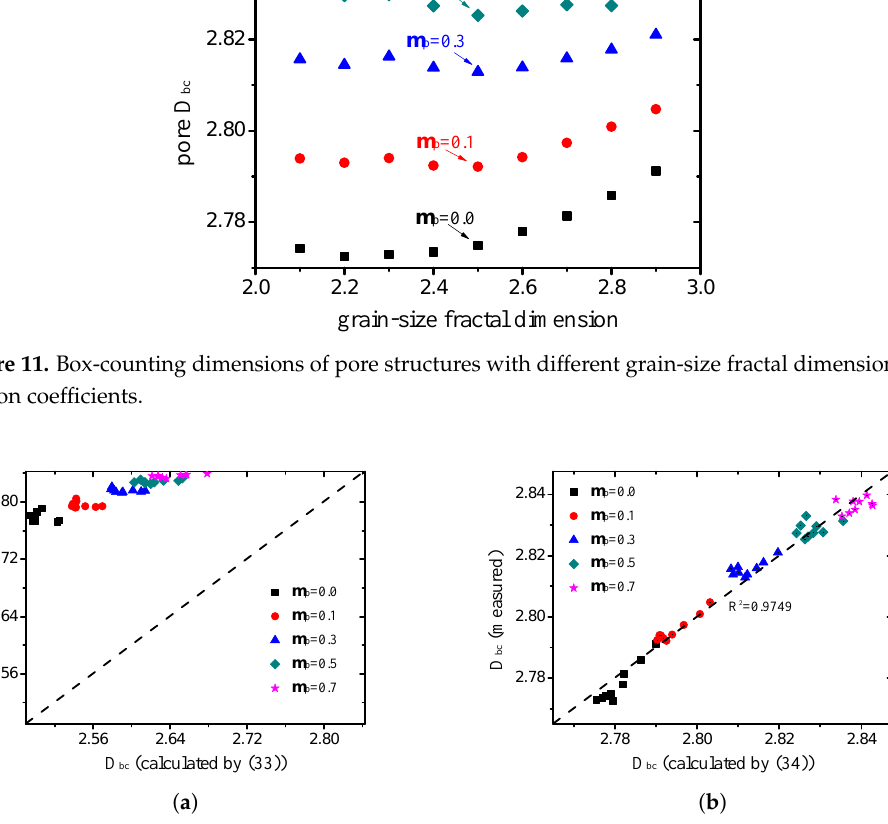
Figure 12. Comparison of box-counting dimensions measured from DEM simulation with values calculated by two different formulae (( a ) analytic solution (33) of ideal fractal structure; ( b ) empirical relationship (34) provided in the present